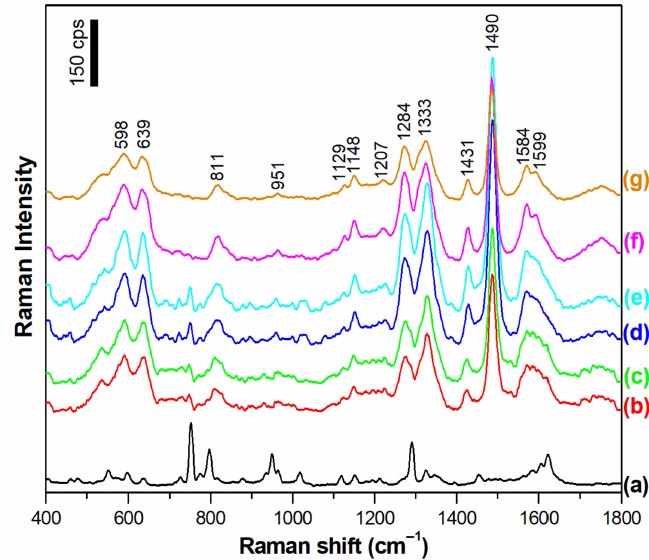
Figure 6. SERS spectra of the dopamine adsorbed on the nanostructured silver electrode from a 10 − 5 M dopamine aqueous solution (a) before the addition of an electrolyte and (b–g) with the addition of NaF. The final concentration of NaF is as follows: (b) 0.1 M, (c) 0.2 M, (d) 0.4 M, (e) 0.6 M, (f) 0.8 M, and (g) 1 M. Excitation wavelength: 532 nm. Accumulation time: 40 s. The spectra was averaged from 10